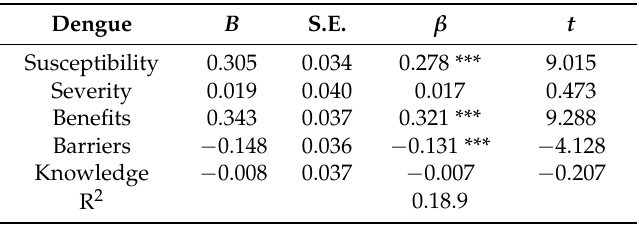
Table 4. Regression of Perceived Susceptibility, Severity, Benefits, Barriers, and Knowledge on the Likelihood of Getting Dengue Vaccine.